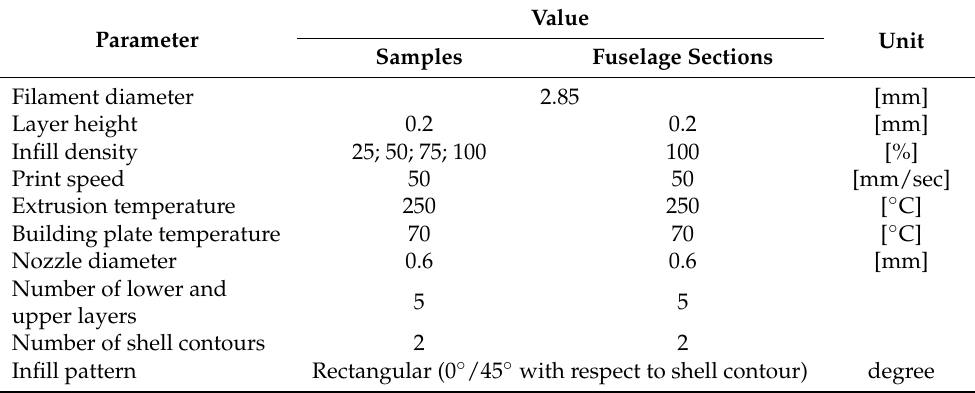
Table 2. Manufacturing parameters for the PLA-GF composite samples and fuselage